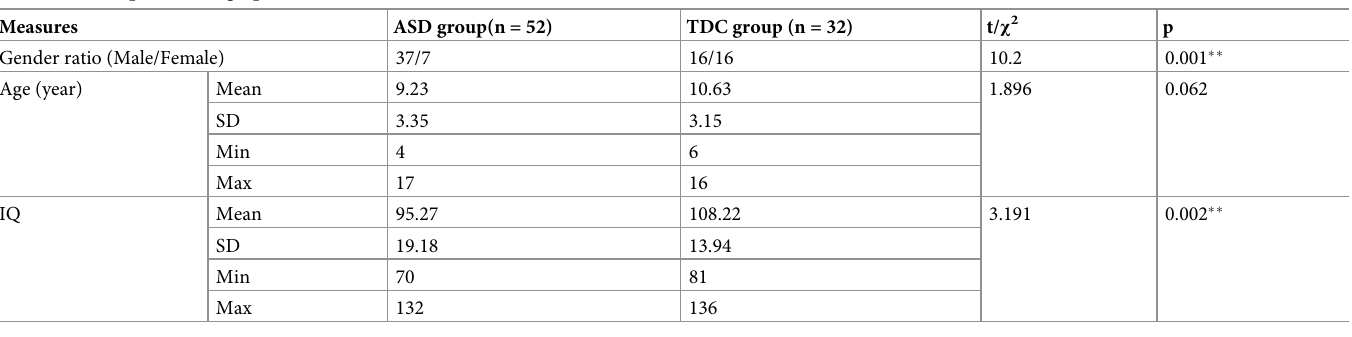
Table 1. Participants demographics